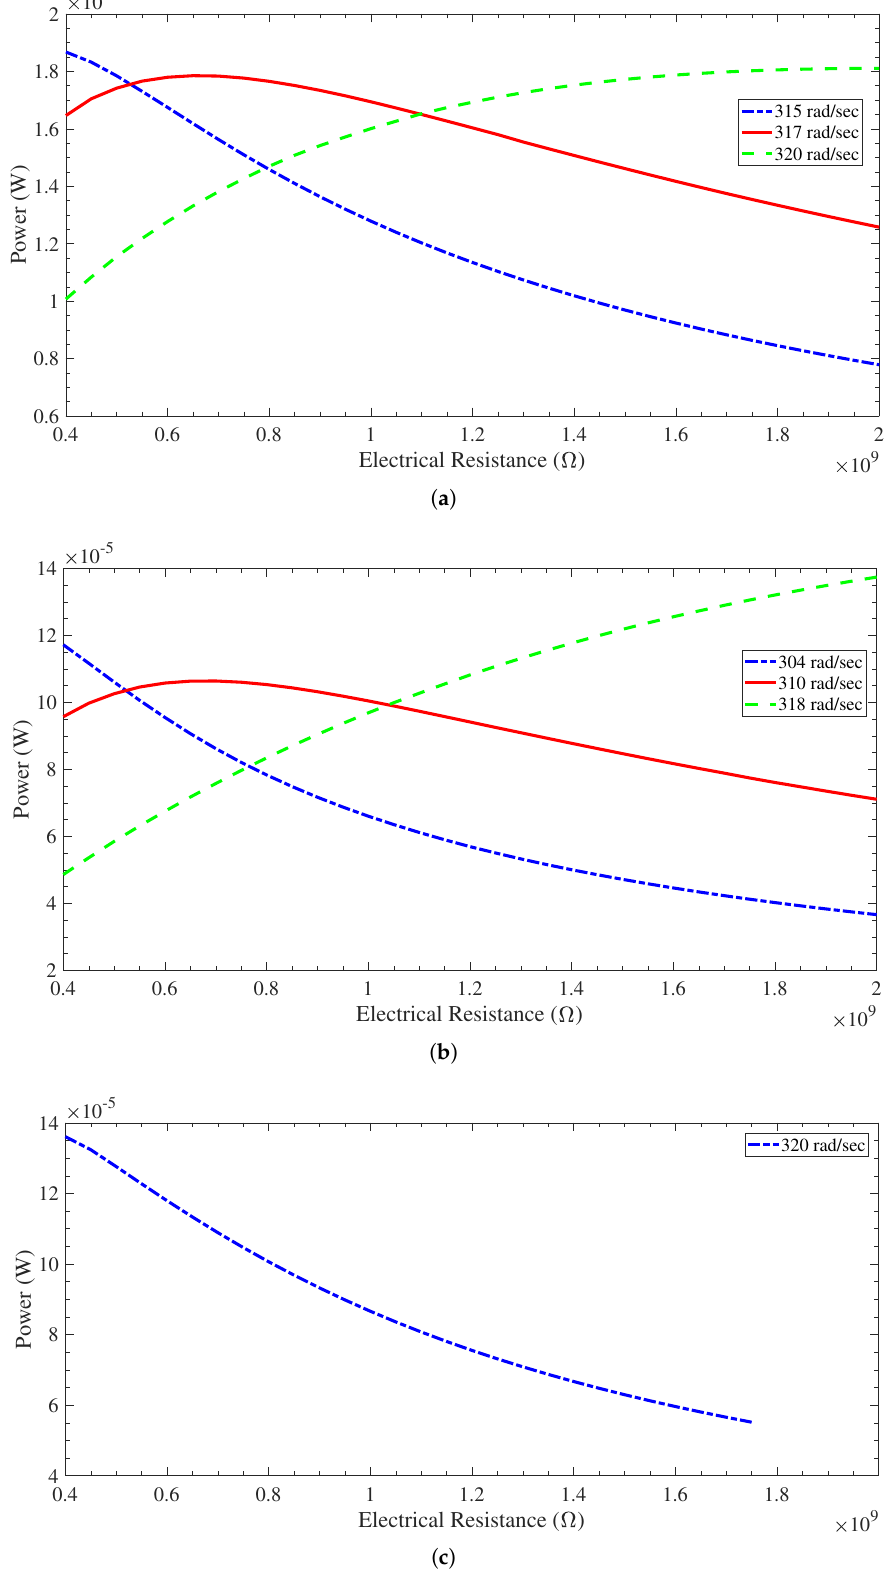
Figure 10. Variations of harvested power as a function of electrical load resistance for a variety of excitation frequencies for ( a ) V et = 1400 V, ( b ) V et = 2400 V, and ( c ) V et = 400